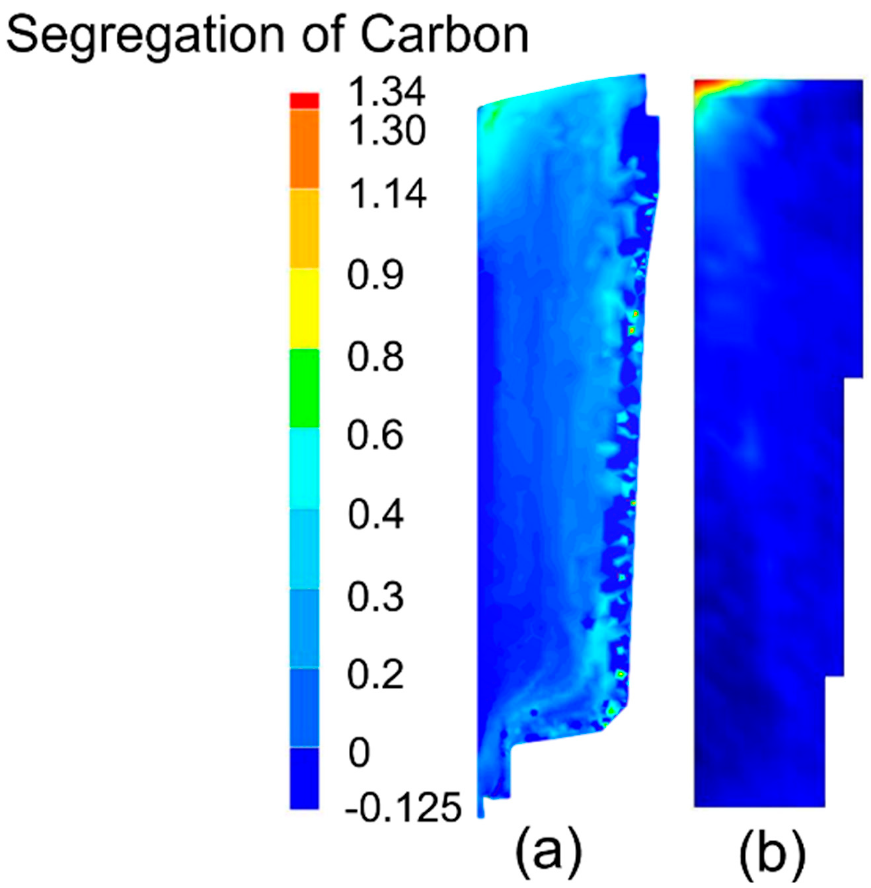
Figure 5. Carbon macrosegregation map: ( a ) Predicted result (90° model), ( b ) Experimental result.